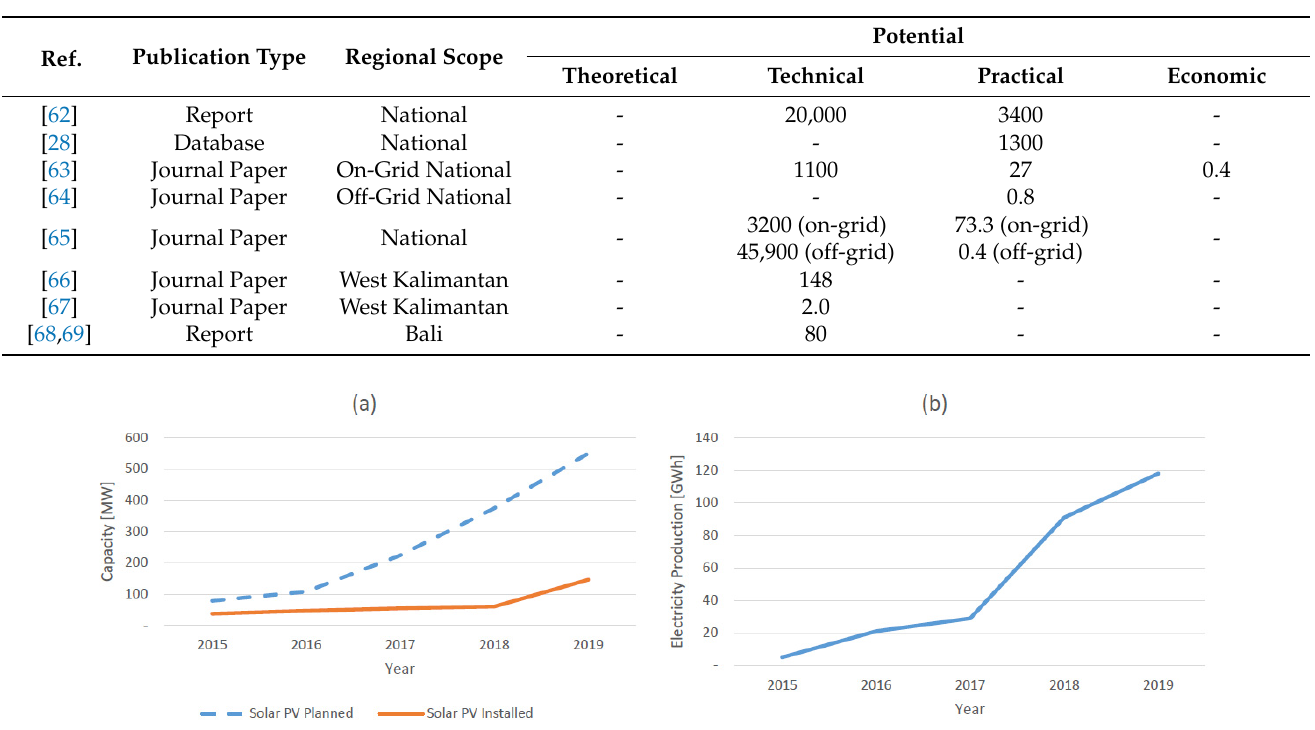
Table 5. Overview of academic and industrial solar PV potential research.